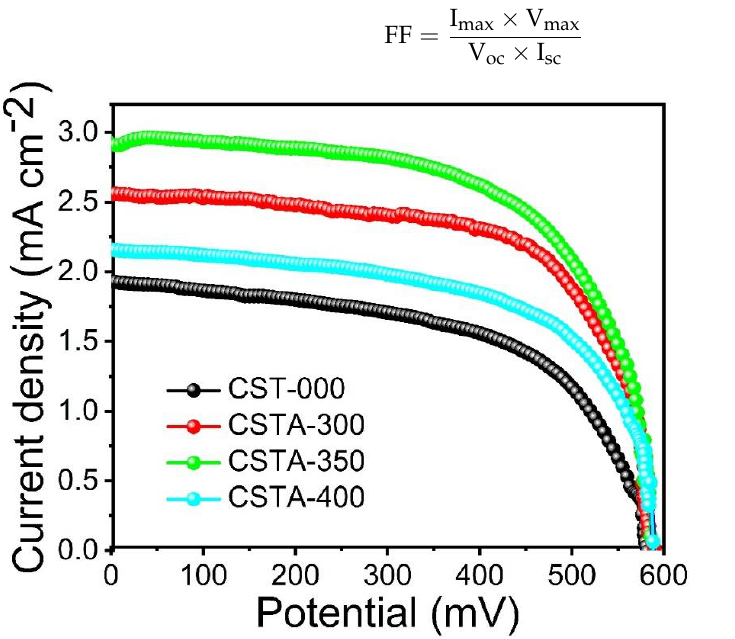
Figure 5. J-V curves of non-annealed CdSe 0.6 Te 0.4 photoelectrodes and air annealing with different temperatures of 300, 350, and 400 ° C.